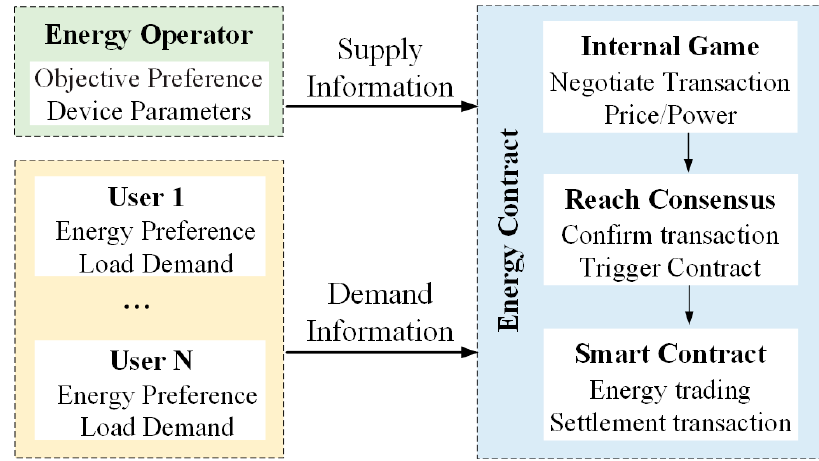
Figure 2. Transaction process based on smart contract.